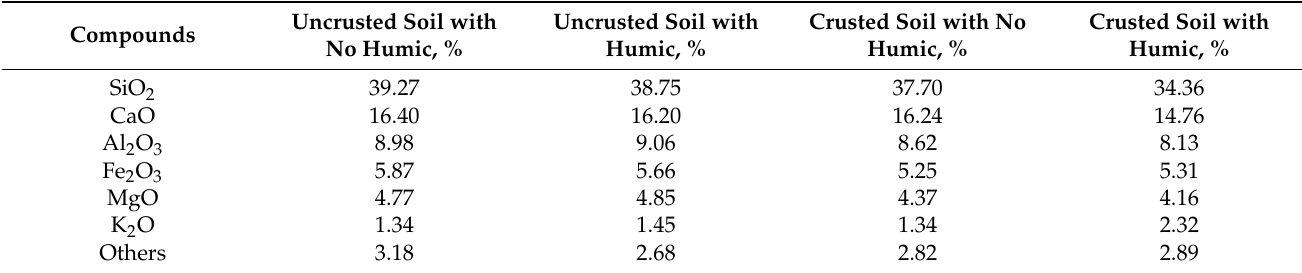
Table 3. Chemical composition of crusted and uncrusted soil samples with humic acid (at three weeks of curing time) and without humic acid (at one week of curing time) using XRF analysis.